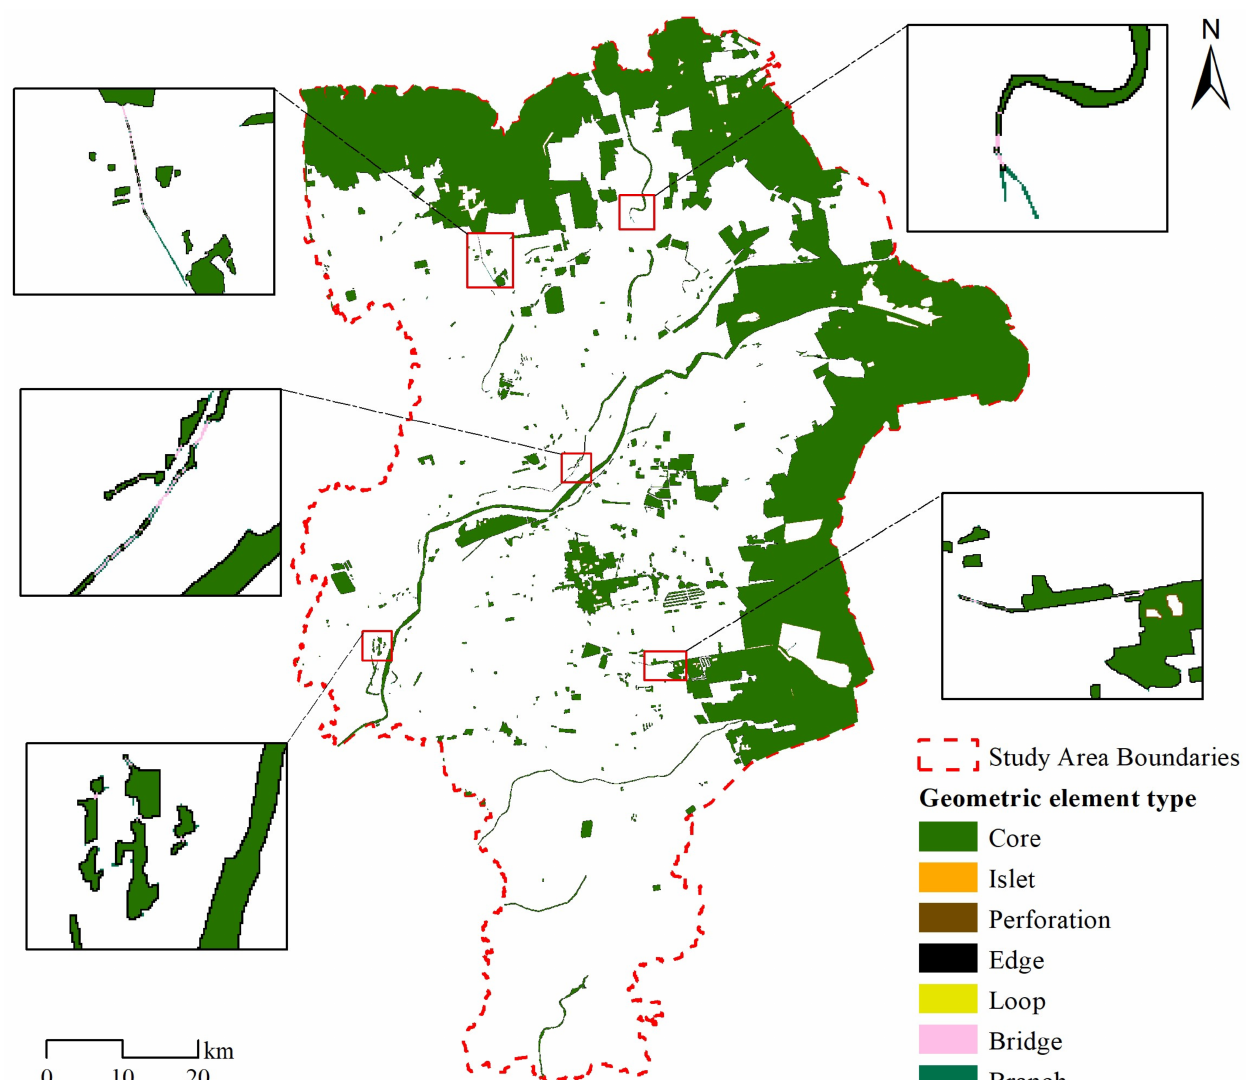
Figure 5. Wetland landscape based on